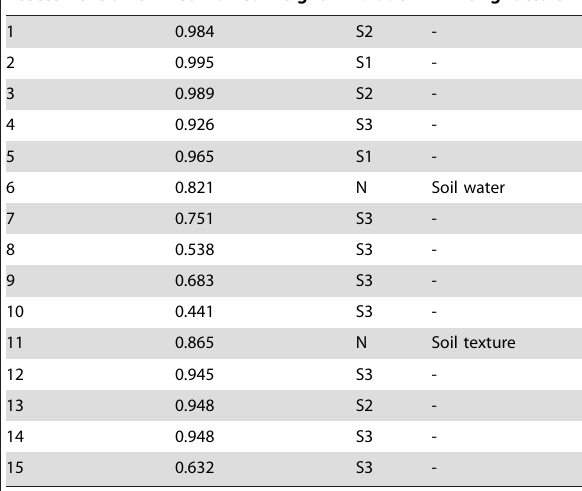
Table 9. Grassland suitability and limiting factors for each assessment unit.